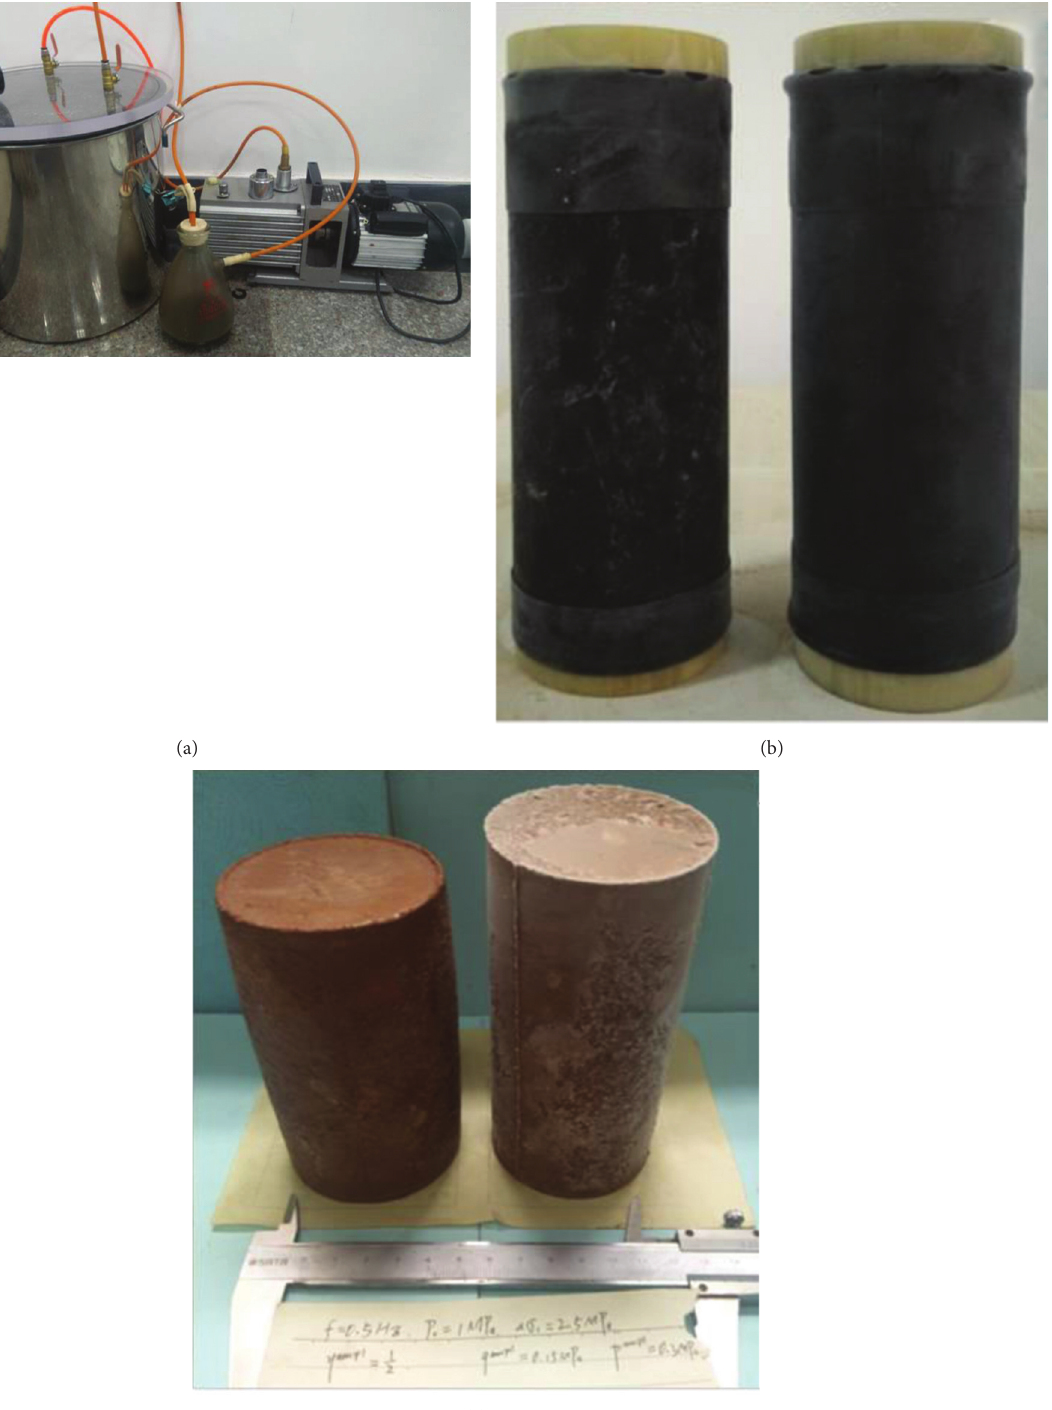
Figure 2: (a) The apparatus used for the air extractor; (b) the prepared samples before the testing; and (c) sample contrast before and after the